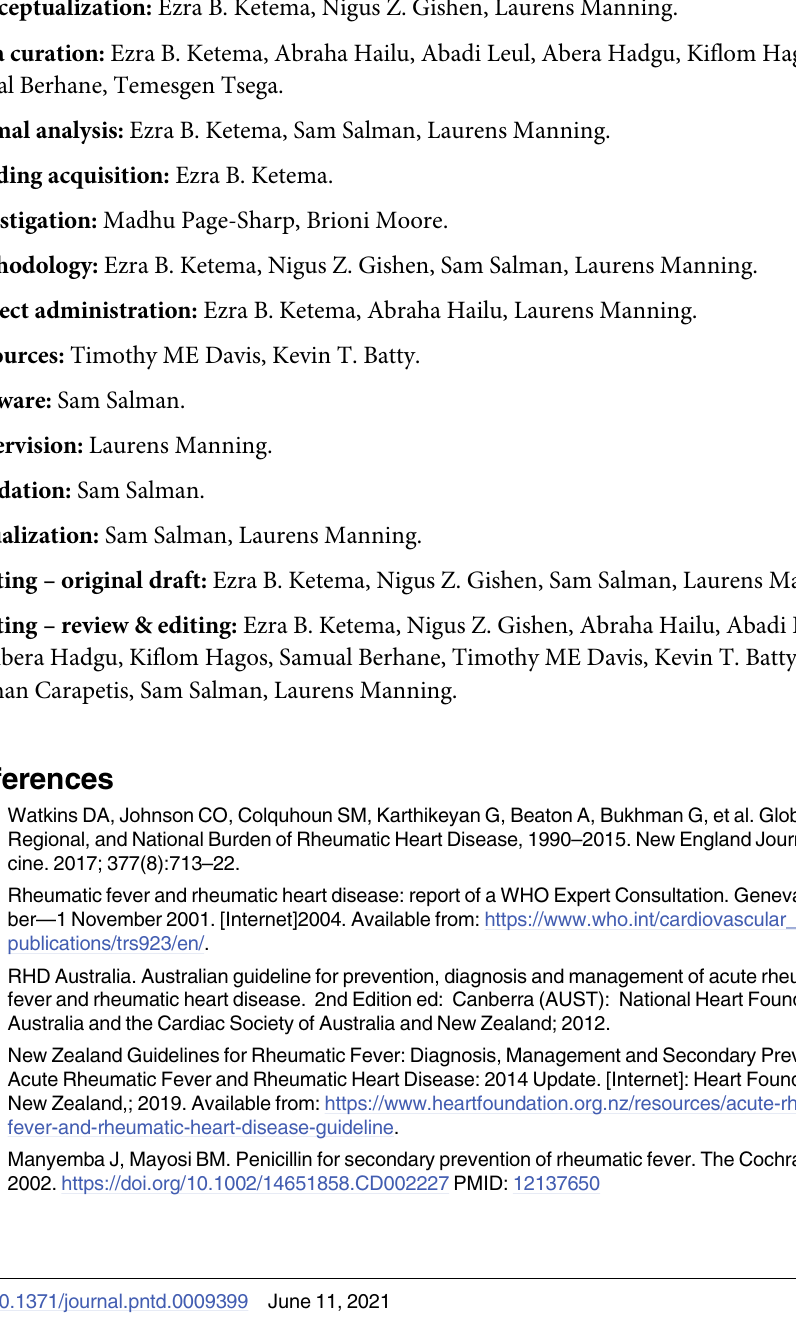
S1 Table. Sociodemographic and clinical characteristics of study participants at Ayder Comprehensive specialized hospital, Mekelle, Ethiopia, between February and October,